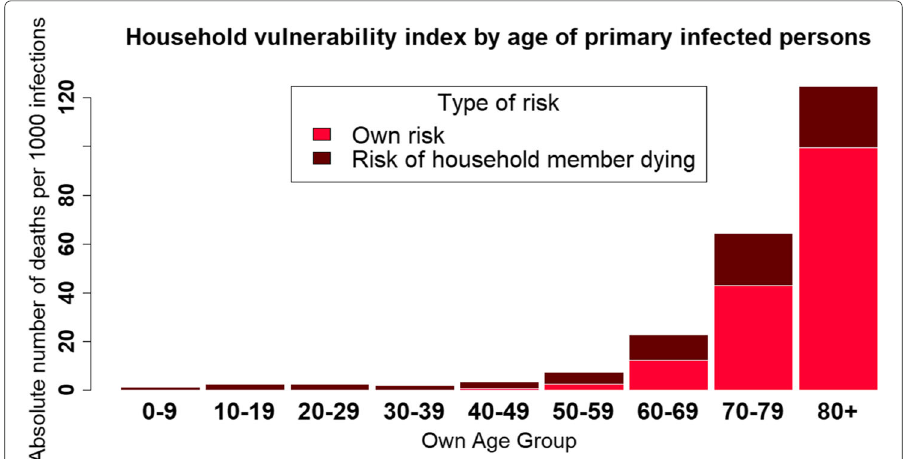
Figure 2 translates the age differences in household composition into risks of dying from COVID-19. For each age group, the figure indicates the expected number of deaths per 1000 random COVID-19 infections. This graph makes the distinction between “direct” and “indirect” deaths according to the decomposition presented in Eq. (2). The lighter part of the bars shows the age gradient of the fatality case ratio computed with French epidemiological data and relates to “direct” deaths, i.e., the risk that primarily infected persons pass away themselves. The darker part indicates additional deaths transmission of the virus to co-residents could cause. These indirect deaths range from 1.2 deaths per